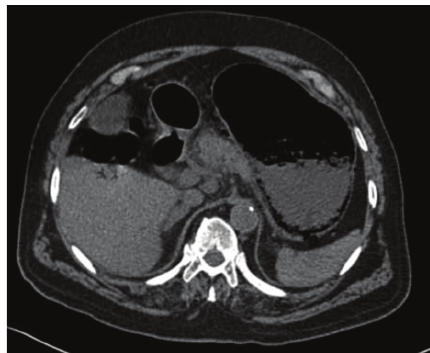
Figure 2: CT showing gas within the posterior gastric wall, indicative of gastric ischaemia (Case 1).